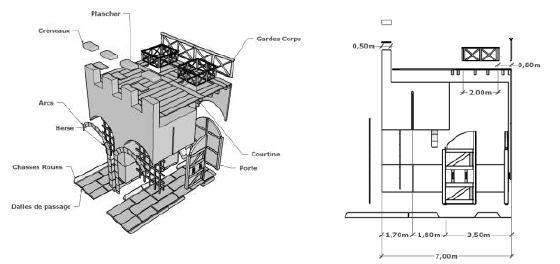
Figure 5. Extract of modelling sheet: entrance of castellum.